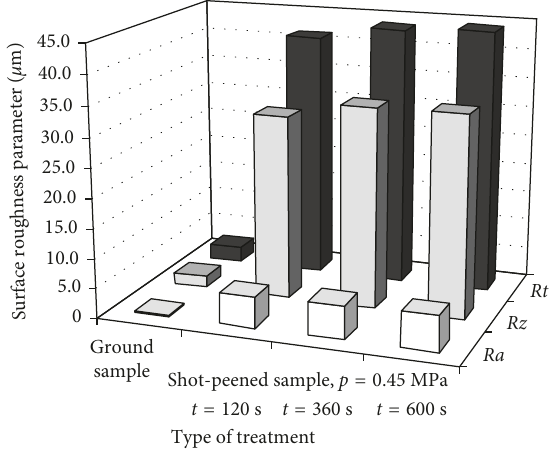
Figure 2: The parameters of surface roughness after grinding process (initial state) and after shot peening